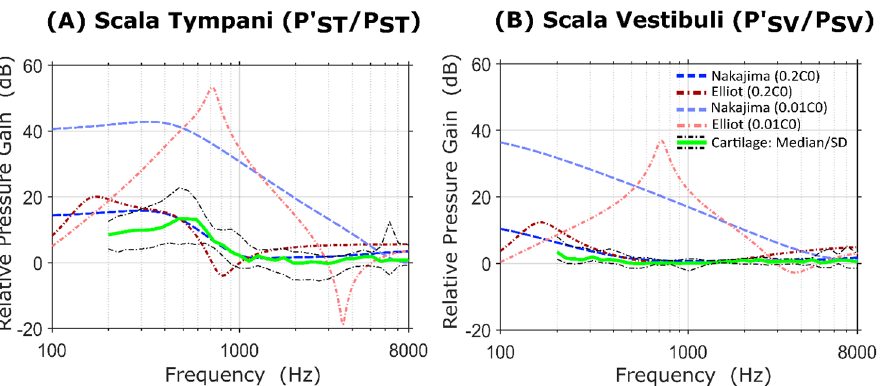
Figure 10. Experimental relative pressure gain values of reinforced RWM with simulated data. Experimental data with cartilage reinforcement (median and SD) and simulated values from two models (Nakajima et al. and Elliot et al.) are represented for ( A ) ST and ( B ) SV. After reinforcement, the RWM inertance is set to twice the initial value to mimic the added mass effect with materials during reinforcement. RWM compliance after reinforcement was set to an initial compliance (C 0 ) of 0.2 and 0.01.